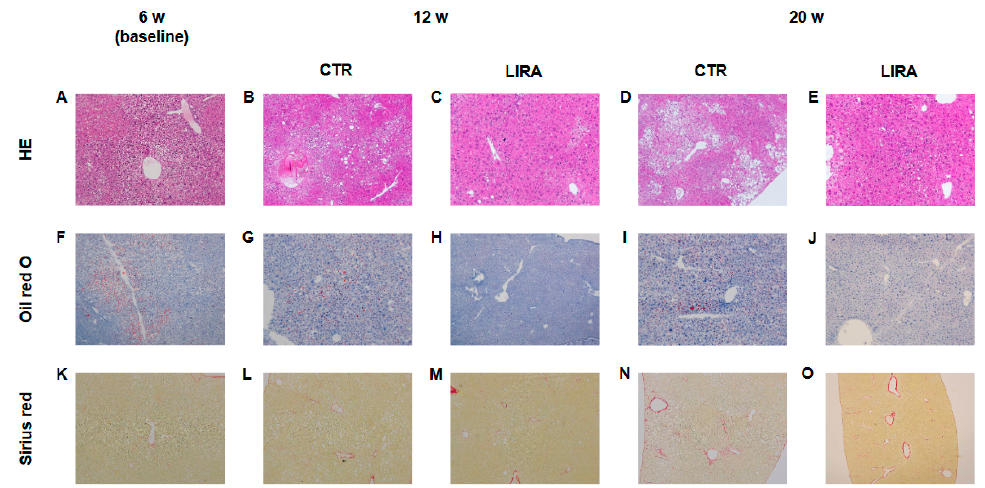
Figure 3. Representative histological images of non-tumorous lesions at 20 weeks (w) of age. Hematoxylin and eosin( A – E ), staining (HE). Oil red O staining ( F – J ). Sirius red staining ( K – O ). LIRA: liraglutide-treated mice; CTR: control mice